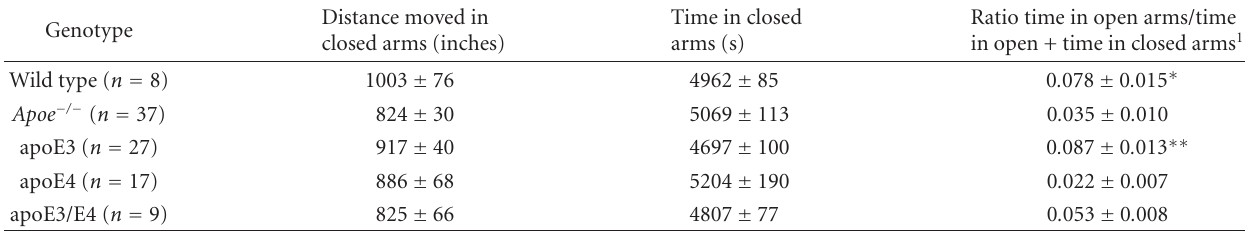
Table 1: Elevated plus-maze performance of 6–8-month-old NSE-apoE mice.